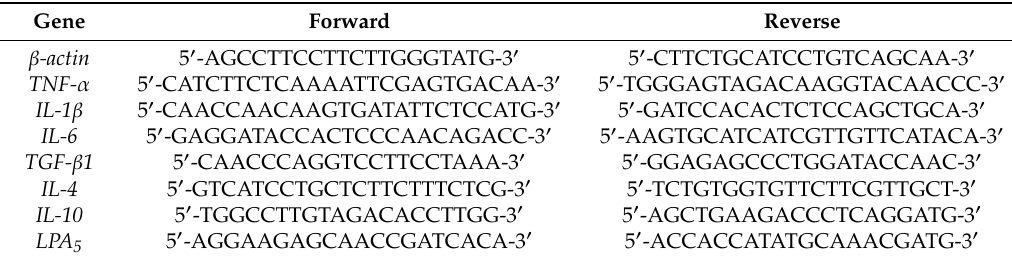
Table 1. Primer sets used for qRT-PCR